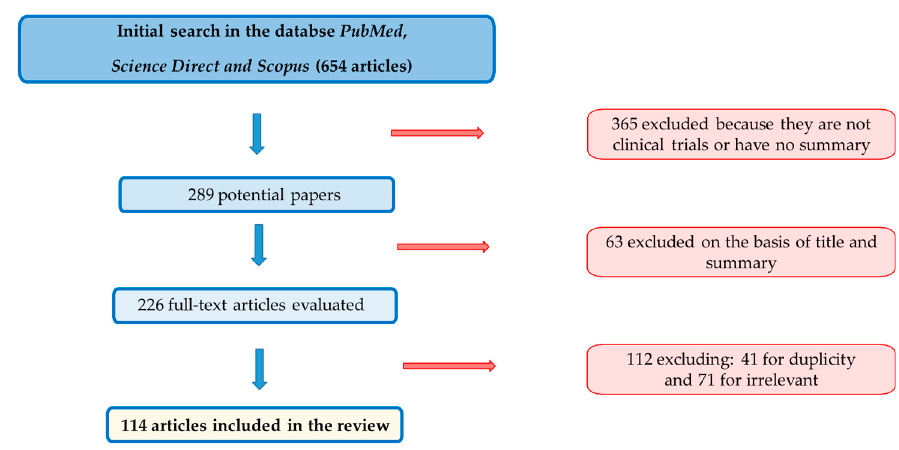
Figure 2. PRISMA flow chart for literature search and selection of articles.